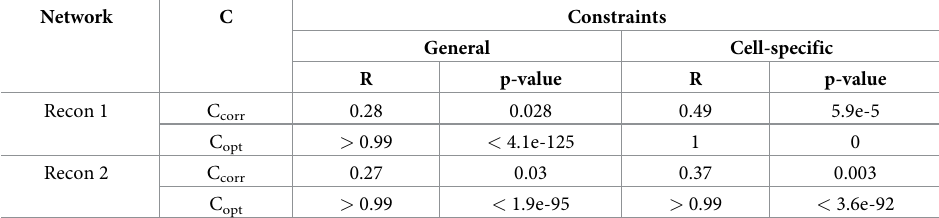
Table 3. Spearman correlation coefficients between predicted and measured growth rates for C corr and C opt